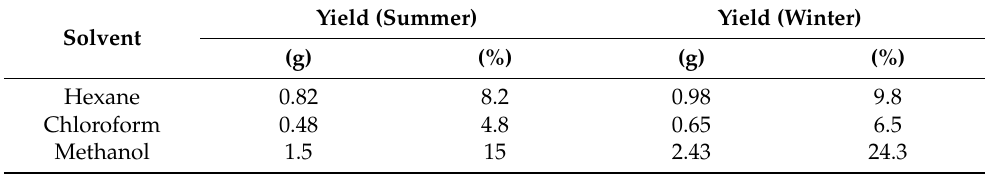
Table 1. Yield percentage of the dried extracts of summer and winter leaves of C. macrocarpa .